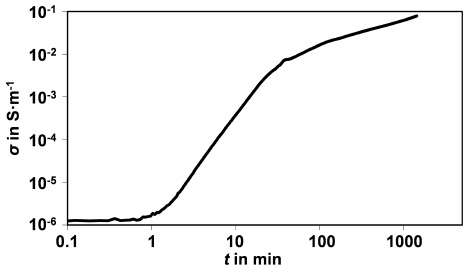
Figure 8. Relative conductivity during sulfidation under 1000ppm H 2 S in N 2 at different temperatures. For the temperature curves at 100 and 150 ◦ C, the measured values were averaged over 10 points.